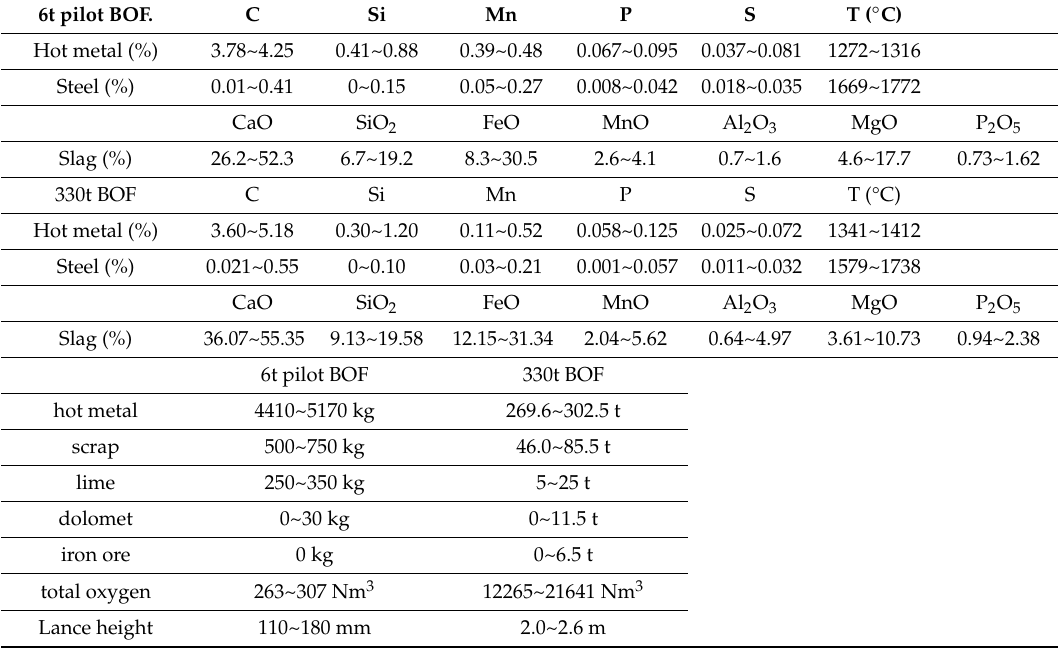
Table 2. The operating conditions for both the six-ton (6t) and 330t converters. 6t pilot